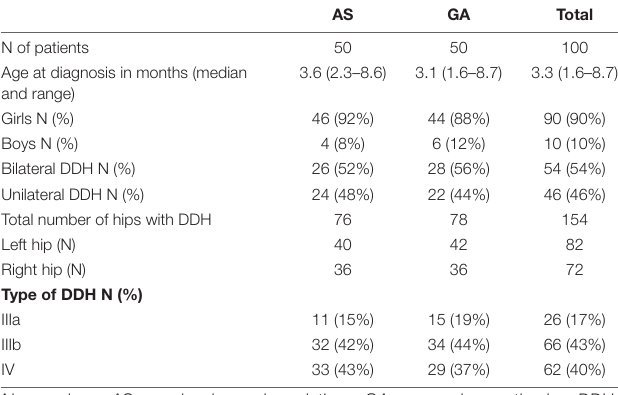
TABLE 1 | Demographic characteristics of patients.